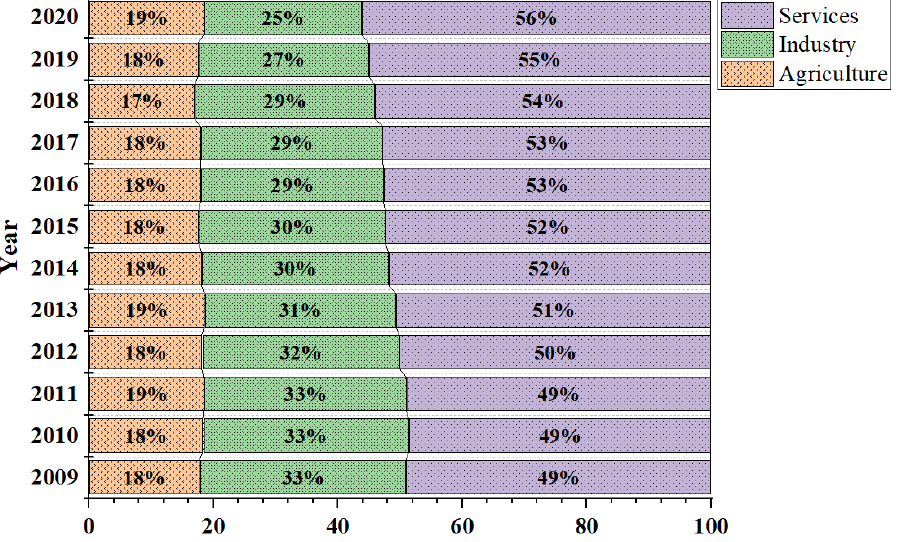
Figure 1. Distribution of GDP across economic sectors in India.